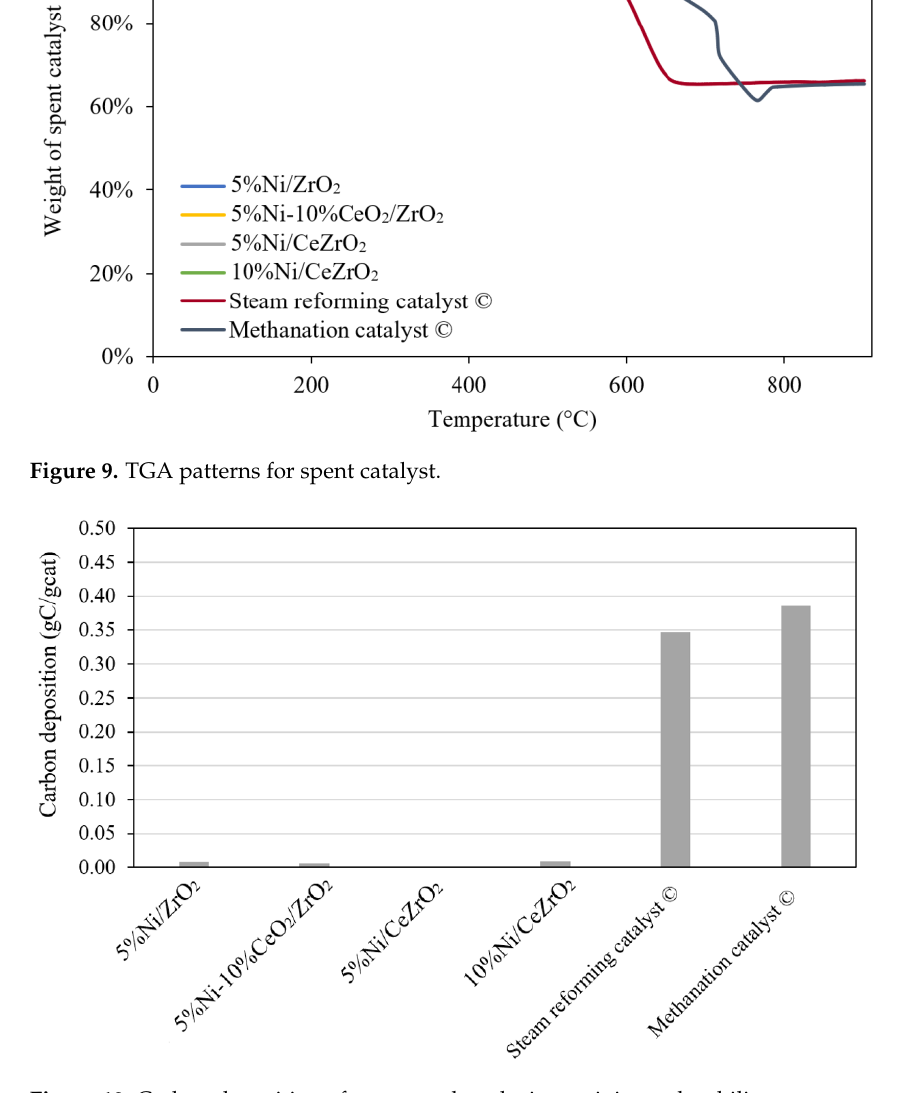
Figure 9. TGA patterns for spent catalyst.